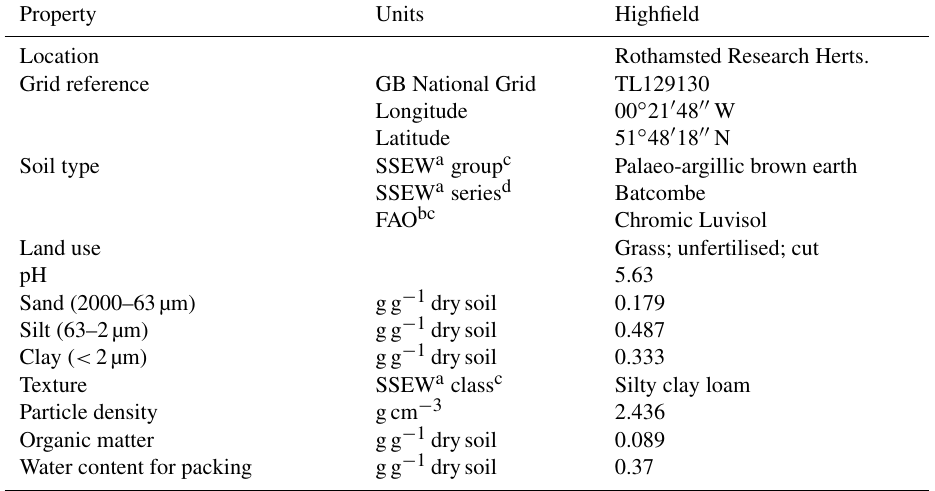
Table 1. Highfield soil